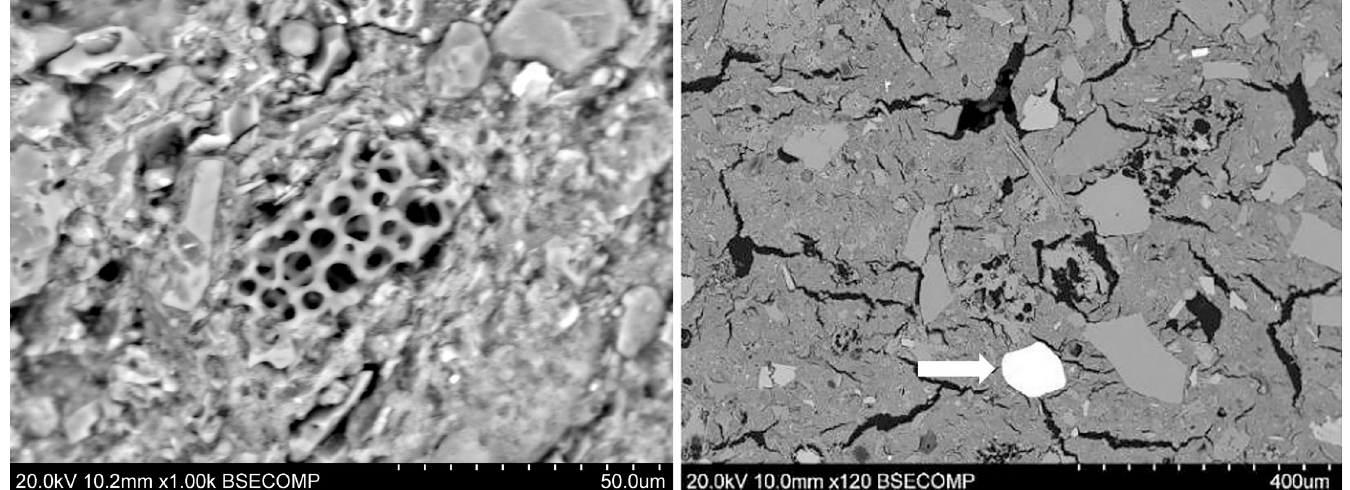
Fig 8. Inclusions detected in the samples. A. Diatom present in IN04 and B. Iron sulfide detected CO08.